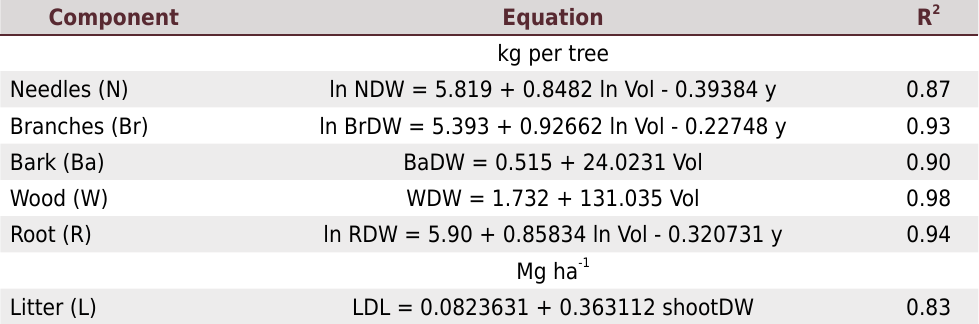
Table 3. Regression equations to estimate the dry weight (DW) of needles, branches, bark, stem wood, roots, and litter in P. taeda stands in Arapoti (PR) Component